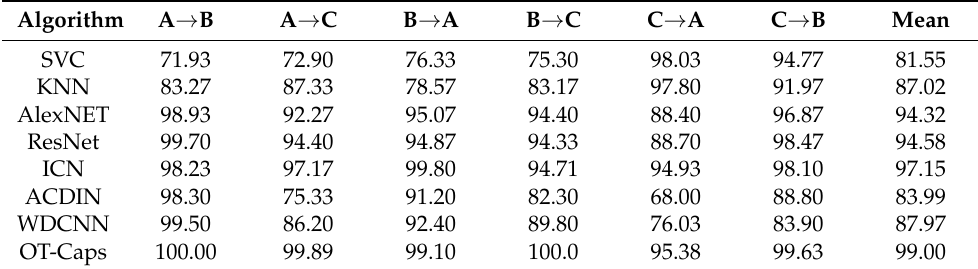
Figure 8. Histogram of failure mode recognition accuracy. Table 5. Comparison of failure mode recognition accuracy.